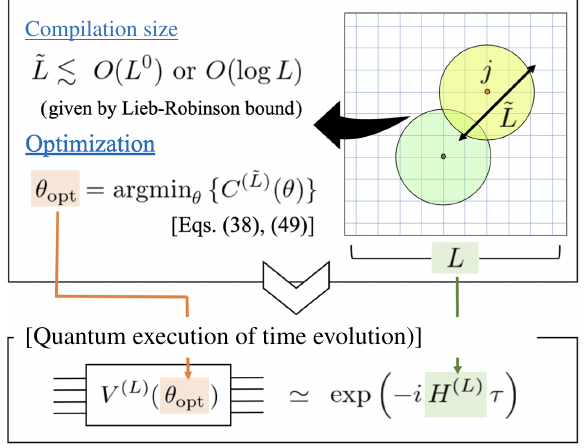
FIG. 1. An overview of the local variational quantum com- pilation (LVQC) protocol. We optimize the cost functions for the compilation size ˜ L , determined by the Lieb-Robinson (LR) bound. For finite-ranged and short-ranged interacting cases, this typically gives ˜ L (cid:2) O ( L 0 ) or ˜ L (cid:2) O ( log L ) . We can directly implement a large-scale time-evolution operator with the optimal parameter θ opt . LVQC can be completed by classical simulation with some approximation or NISQ devices, without implement- ing the target exp ( − iH ( L ) τ)